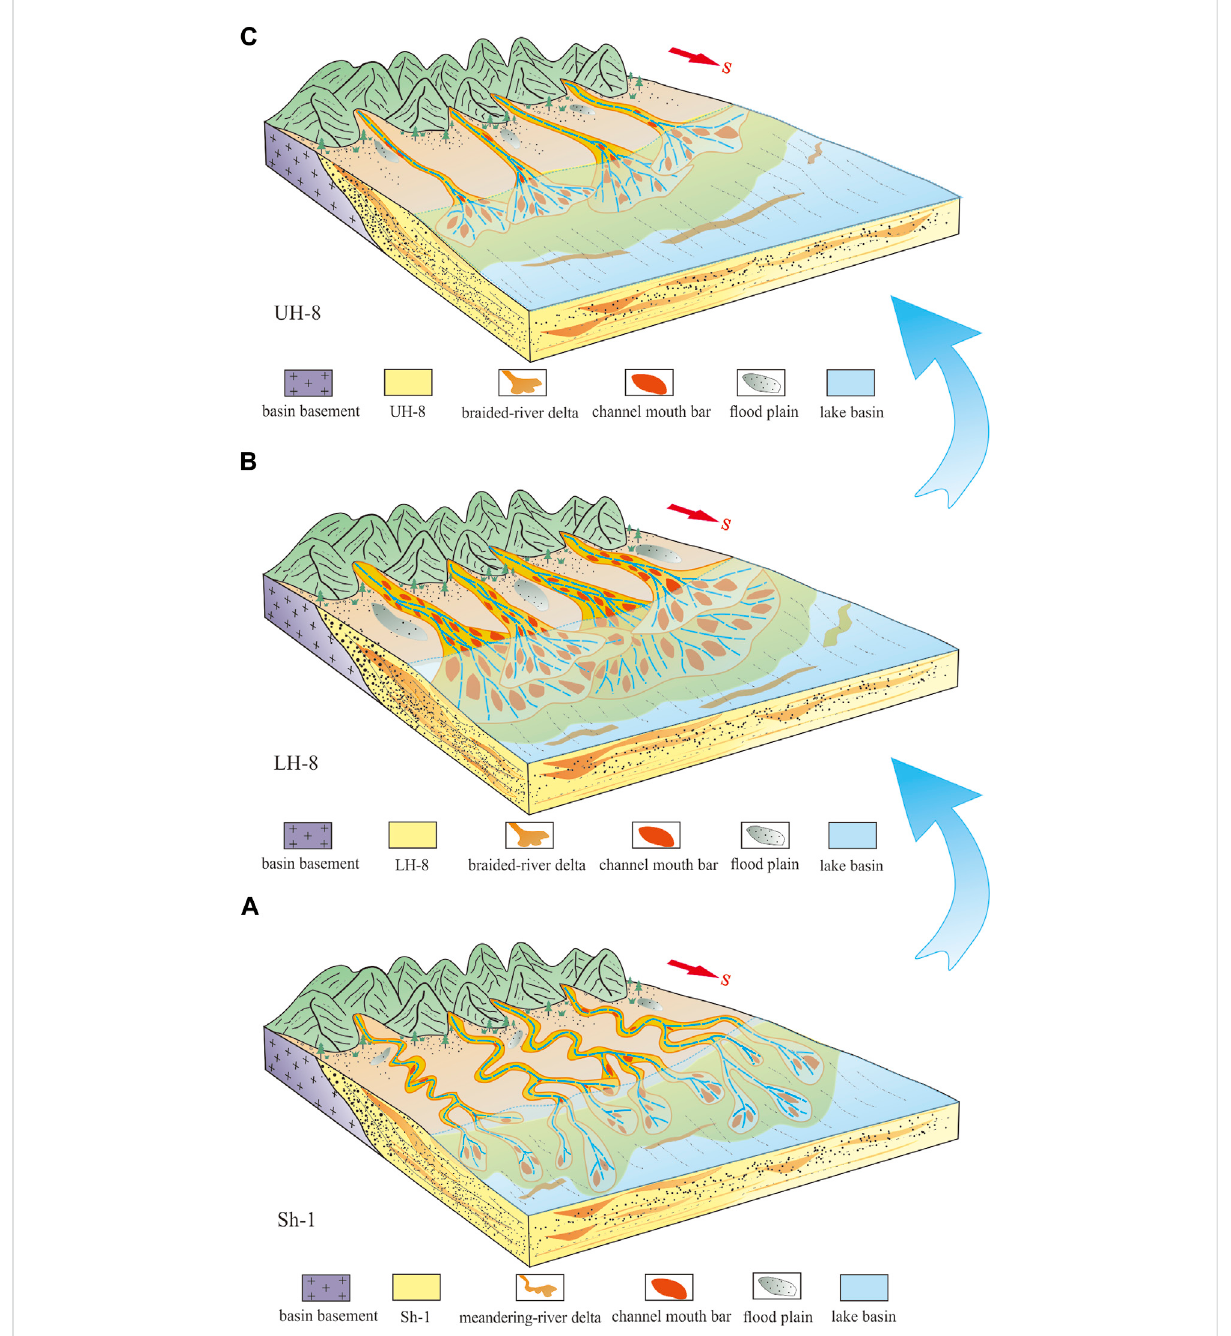
FIGURE 8 Sedimentary evolution model of the delta in the Sh-1 to He-8 members in the Tianhuan Depression, the Ordos Basin. (A) Sedimentary environment of the Sh-1 member, (B) sedimentary environment of the LH-8 member, and (C) sedimentary environment of the UH-8